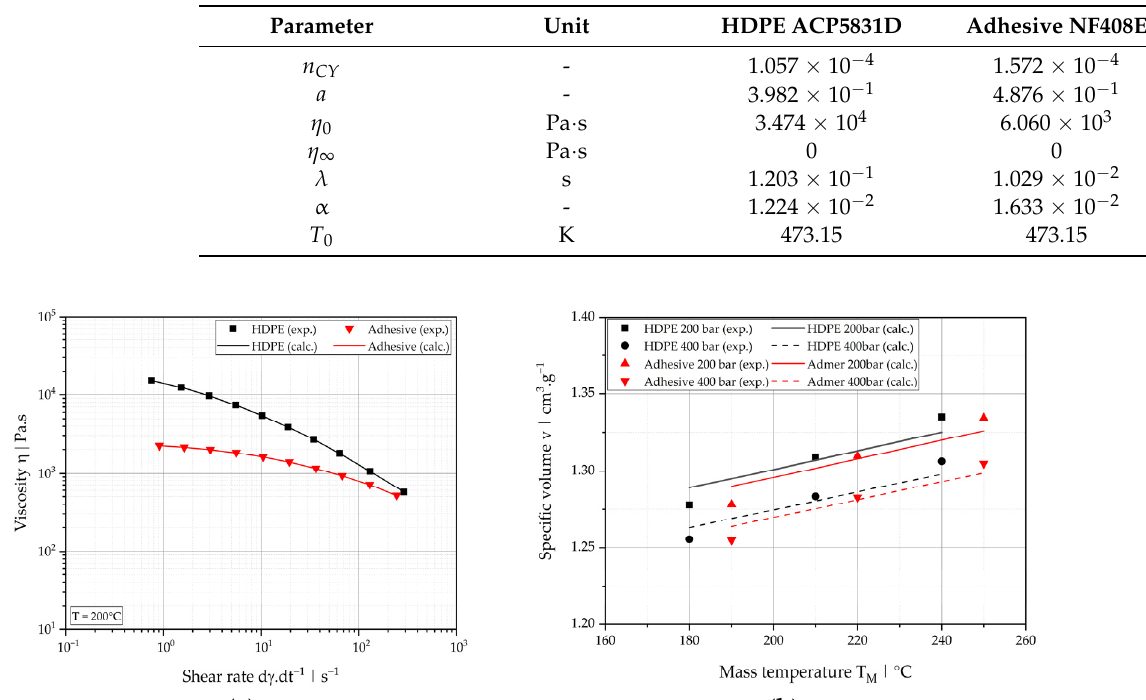
Figure 2. Process-relevant material properties: ( a ) viscosity data at T = 200 °C and ( b ) pvT data at p = 200 bar and 400 bar for HDPE ACP5831D and adhesive NF408E.